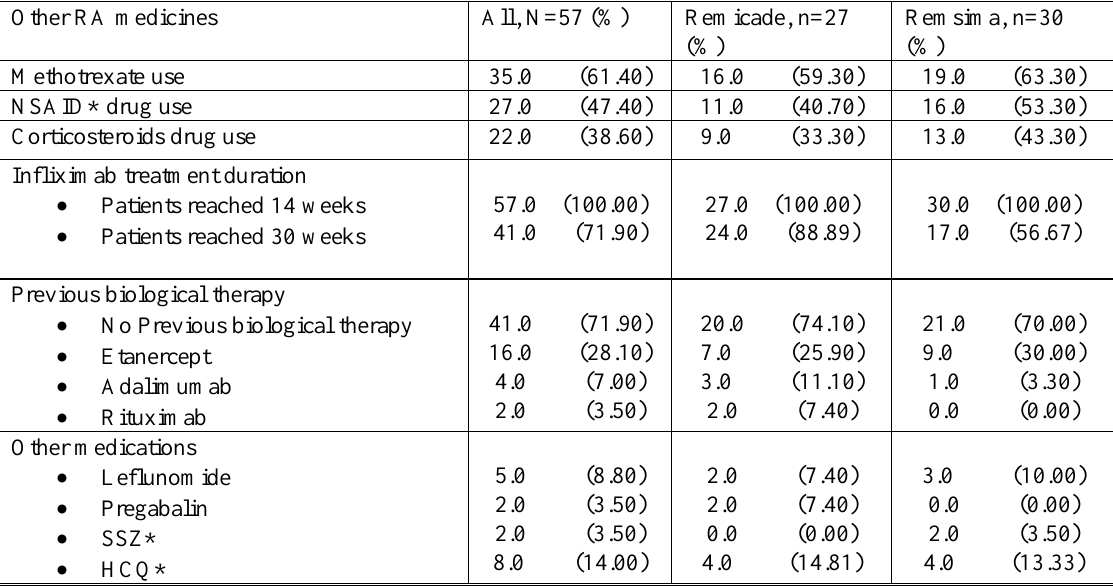
Table 3. The medication history of the participating RA